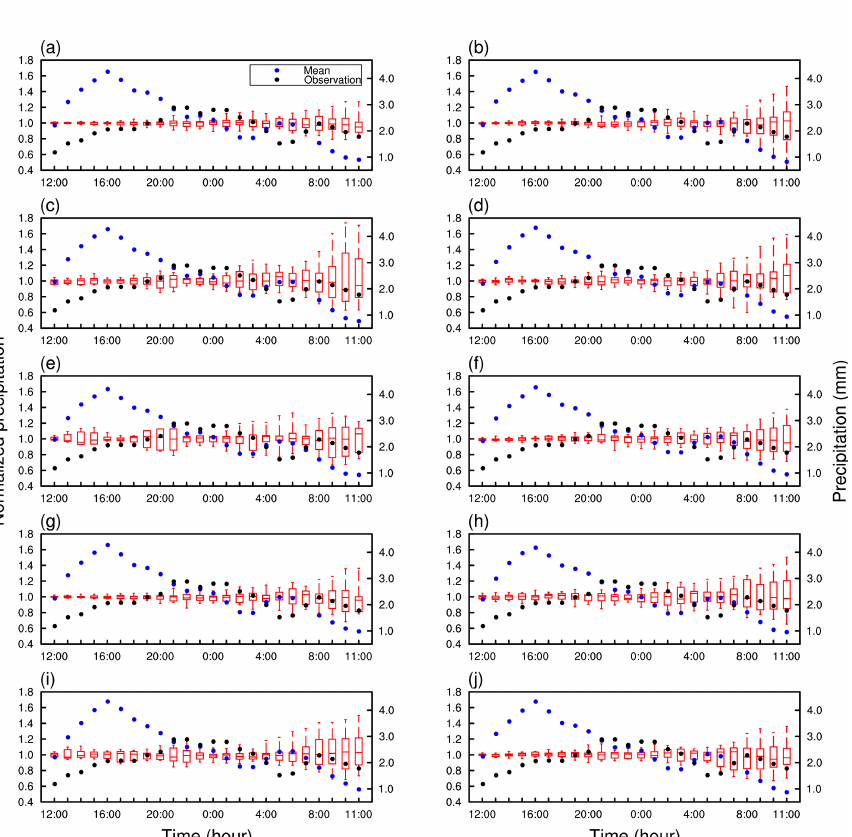
Figure 16. The IQR boxes of hourly precipitation normalized by their mean values (left axis) for each uncertainty parameter at 24 instants from 12:00 UTC to 11:00 UTC. The blue dots and black dots represent the mean of the simulated hourly precipitation and corresponding observation (right axis), respectively. Panels from ( a – j ) stand for P1 to P10, respectively.